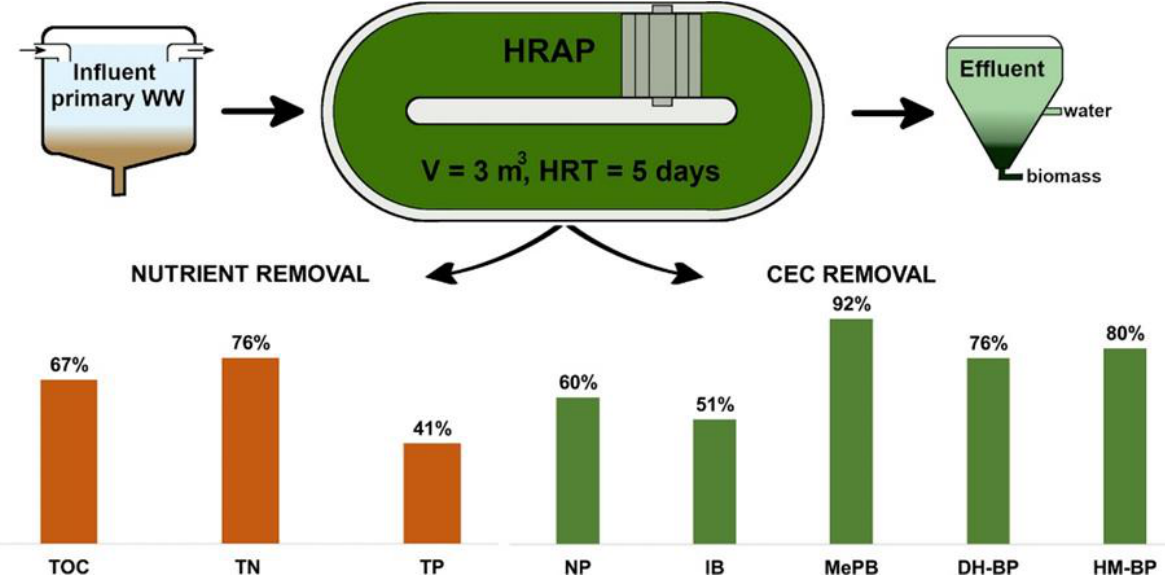
Figure 13. Performance of high-rate algal ponds (HARP) for the treatment of municipal wastewater. Adapted from the work of David Škufca et al. [82] . Reused under the Creative Commons license.